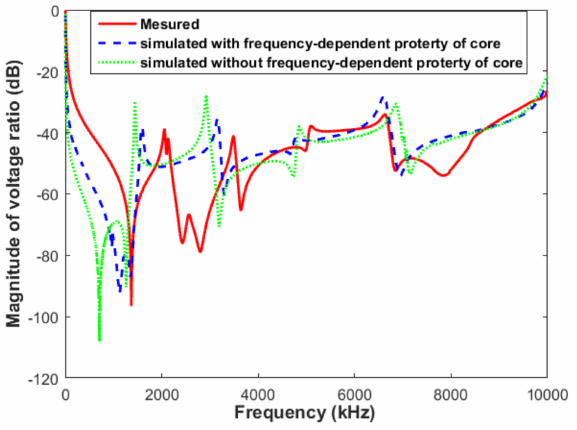
Figure 8. Comparison of frequency response analysis (FRA) results between simulation and